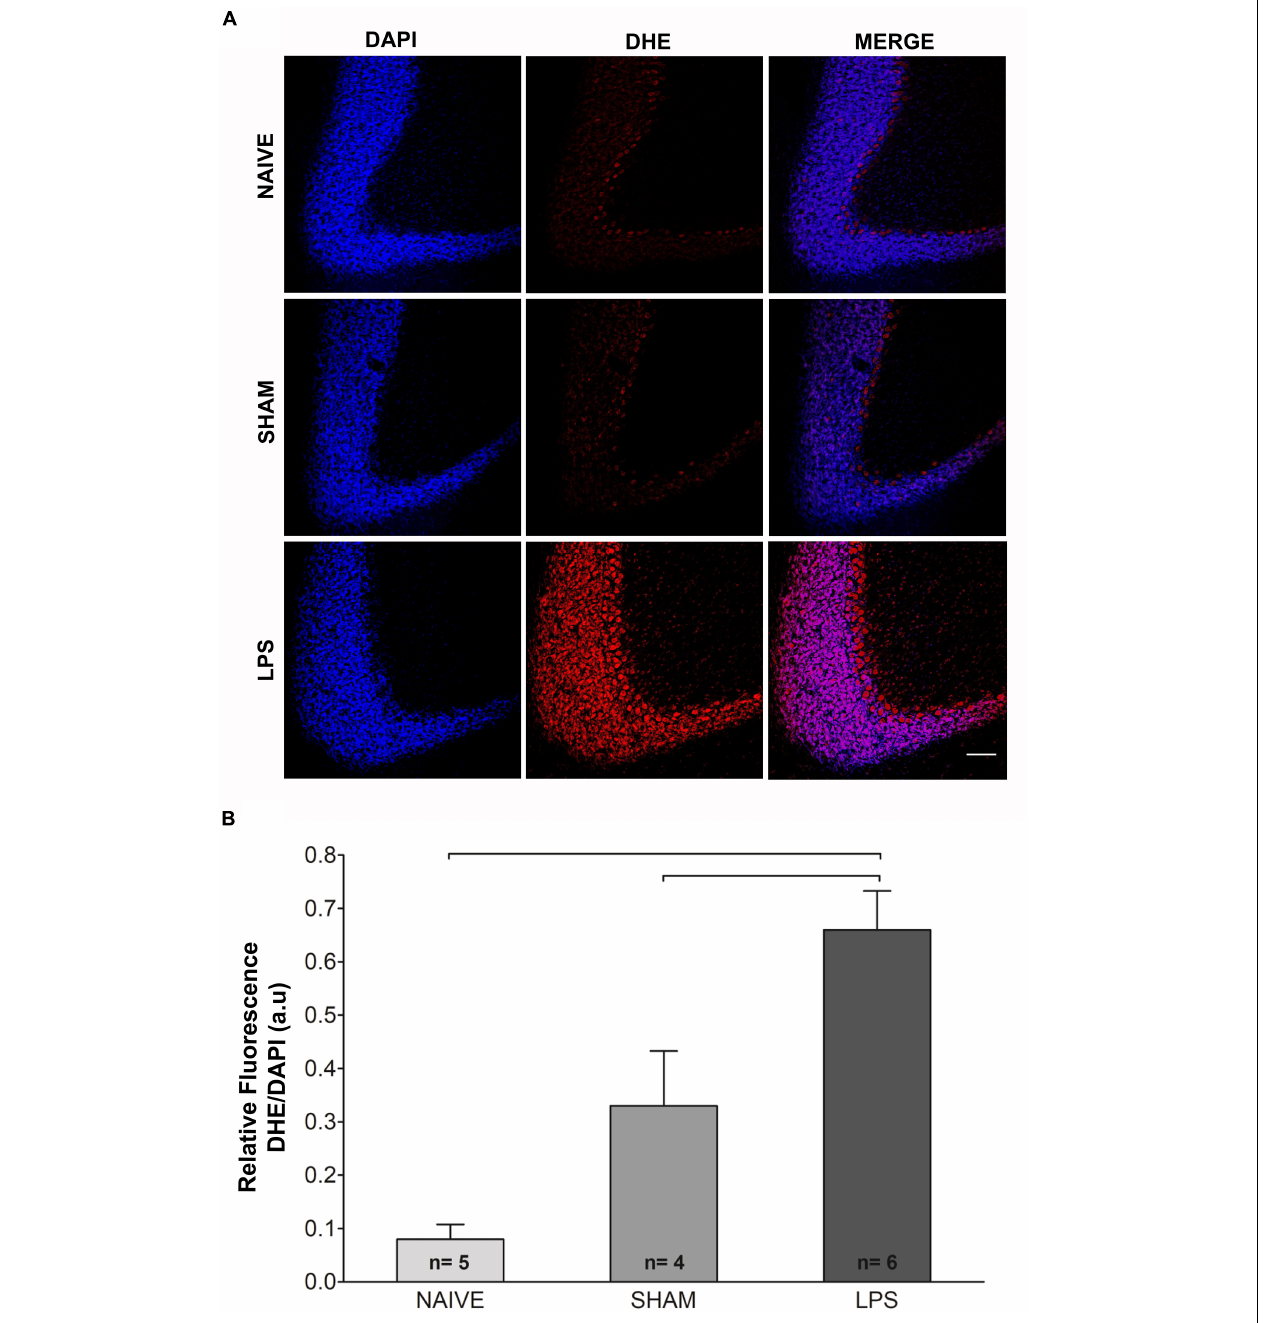
FIGURE 2 | Photomicrographs and fluorescence ratio of reactive oxygen species in the cerebellum of adult rats (PN89) after early neonatal LPS induced inflammation. (A) Increased signal fluorescence of DHE staining in the LPS group as compared to control groups. Calibration bar: 200 µ m. (B) Quantification of the DHE/DAPI fluorescence ratio shows marked increase in the LPS group. Values: mean ± SEM; ANOVA, Tukey post hoc test, bars: p < 0.001 vs control groups. DHE, dihydroethidium.